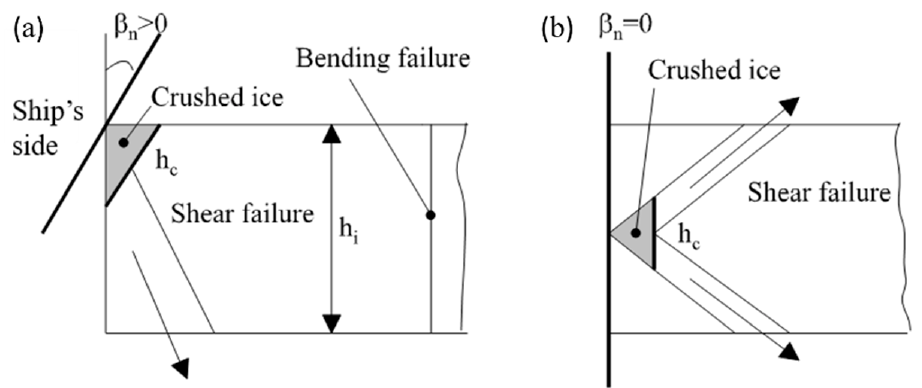
Figure 1. An idealization of the ice edge failure process in a case of ( a ) small to large frame angles and ( b ) vertical frames. Reproduced from [23], with permission from Finnish Academy of Technology, 1994. β n , h c , and h i denote the frame angle, contact height, and ice thickness, respectively.